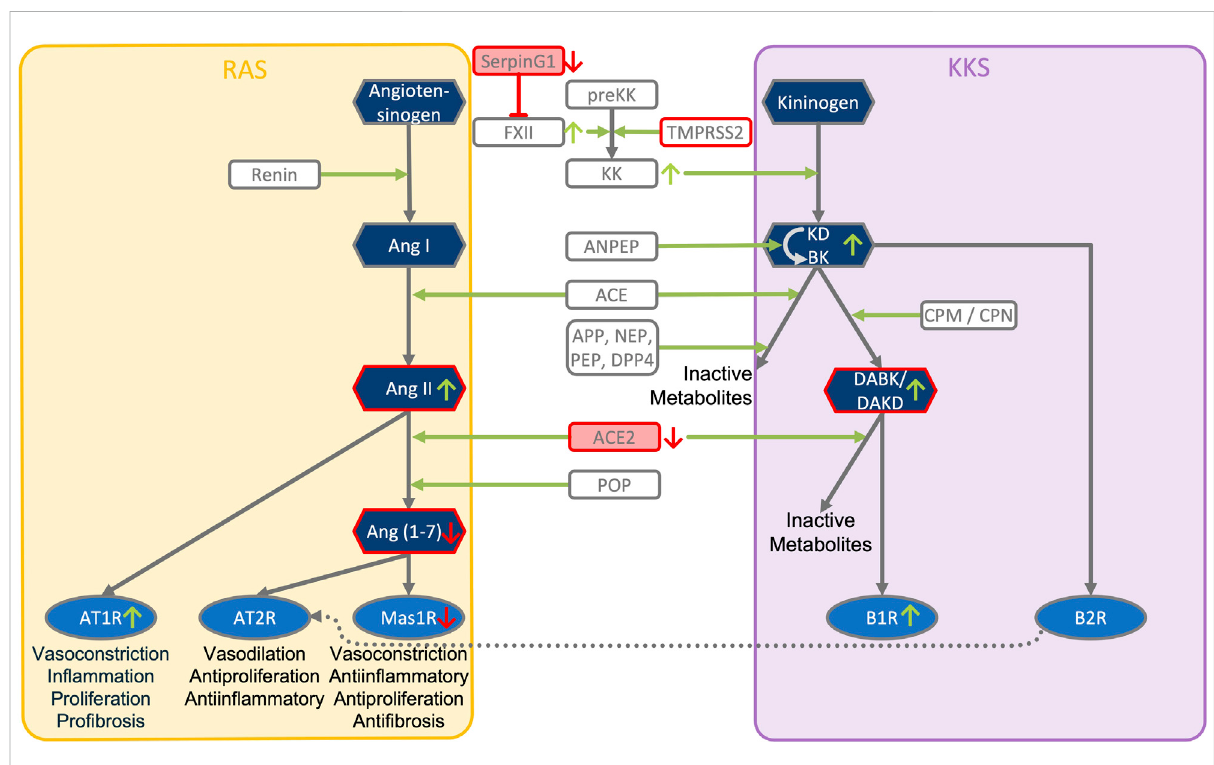
FIGURE 3 ACE2, SERPING1 and ACE2 converge at the crosstalk between KKS and RAS pathways. The KKS comprises the kininogens, the kallikreins, the kinins and the kinin receptors. KK, Kallikrein is generated from preKK, prekallikrein by factor XIIa during activation of CAS. FXIIa can be inhibited by SERPING1ofthecomplementsystem.Kininsaregeneratedbycleavageofkininogensbykallikreins.KininsareBK,bradykininandLys-BK(Kallidin,KD) which both activate B2R, and their active des-Arg metabolites, generated by CPM/N, des-Arg (Brock et al., 2022)-BK (DABK) and des-Arg (Hoffmann et al., 2020)-KD (DAKD), which activate B1R. In this fi gure, the RAS, renin-angiotensin system has been reduced to key components comprisingtheangiotensins(AngI,II,1 – 7),theangiotensinreceptors(AT1R,AT2R,Masreceptor)andtheACEs,angiotensinconvertingenzymes.KKS andRASaremainlyconnectedbyACEandACE2. ACE(kininaseII)inactivatesthekininsandgeneratesangiotensin II(AngII).ACE2inactivatestheB1R agonist DAK,des-Arg kinins and also metabolizes AngII into the Ang-one to seven agonist of AT2R and Mas oncogene.SystemicAngII conversionto Ang (1 – 7) depends on POP, Prolyloligopeptidase and is ACE2 independent. APP, Aminopeptidase P; NEP, Neprilysin; PEP, Prolylendopeptidase inactivate kinins. AT2R directly interacts with B2R through heterodimerization and AT2R overexpression increases KK activity. Simultaneous downregulation of SERPING1 and ACE2 leads to accumulation of excess DAK (DABK and